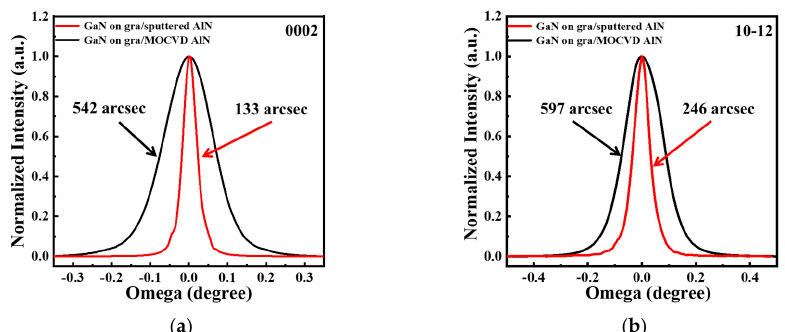
Figure 6. ( a ) (002) and ( b ) (102) rocking curves of the GaN epilayer grown on graphene/sputtered AlN/sapphire and graphene/MOCVD AlN/sapphire substrates.